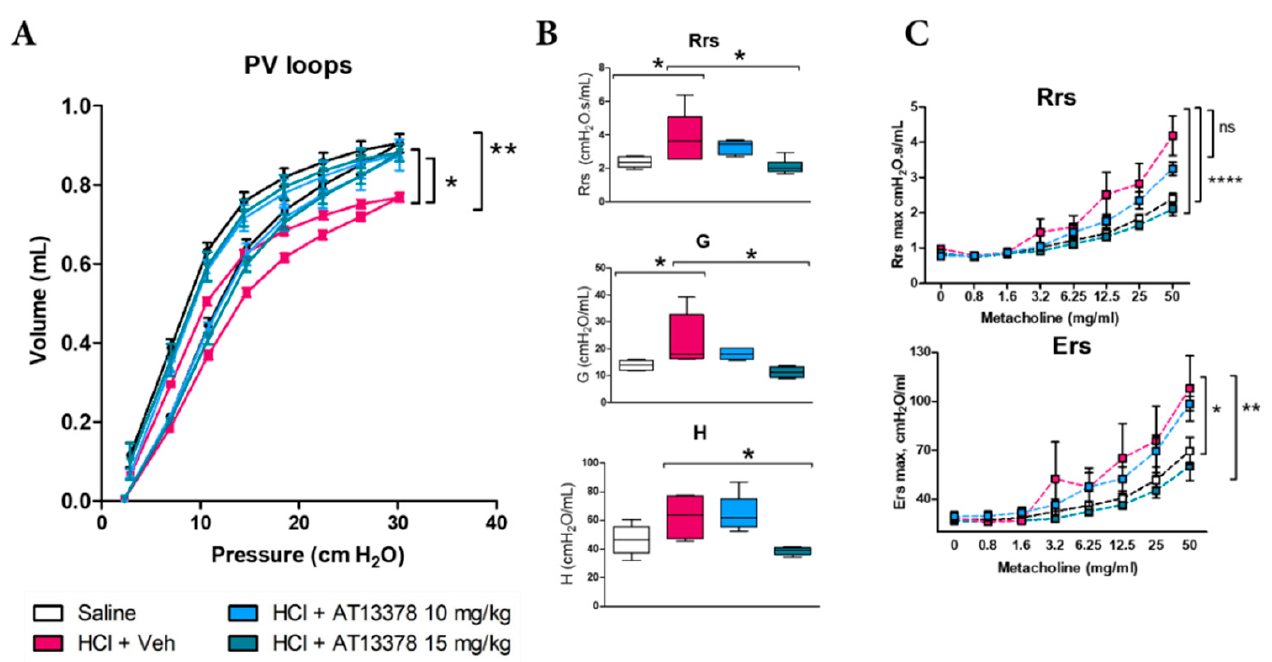
Figure 4. HCl causes lung dysfunction and airway hyperreactivity, blocked by AT13387. ( A ) Pres- sure–Volume relationships in mice after HCl instillation and treatment with vehicle or AT13387 s.c. 3×/week at 10 or 15 mg/kg. ( B ) Total Respiratory System Resistance (Rrs), tissue damping (G), and tissue elastance (H). ( C ) Rrs and total Respiratory System Elastance (Ers) were also evaluated in response to increasing concentrations of aerosolized methacholine. All studies were performed at 30 days after HCl instillation. n = 4–5 mice per group; ns: not significant, *: p < 0.05; **: p < 0.01, ****: p < 0.0001 with 2-way ANOVA and Bonferroni’s post-test ( A ), ( C ) or 1-way ANOVA and Tukey’s ( B ).